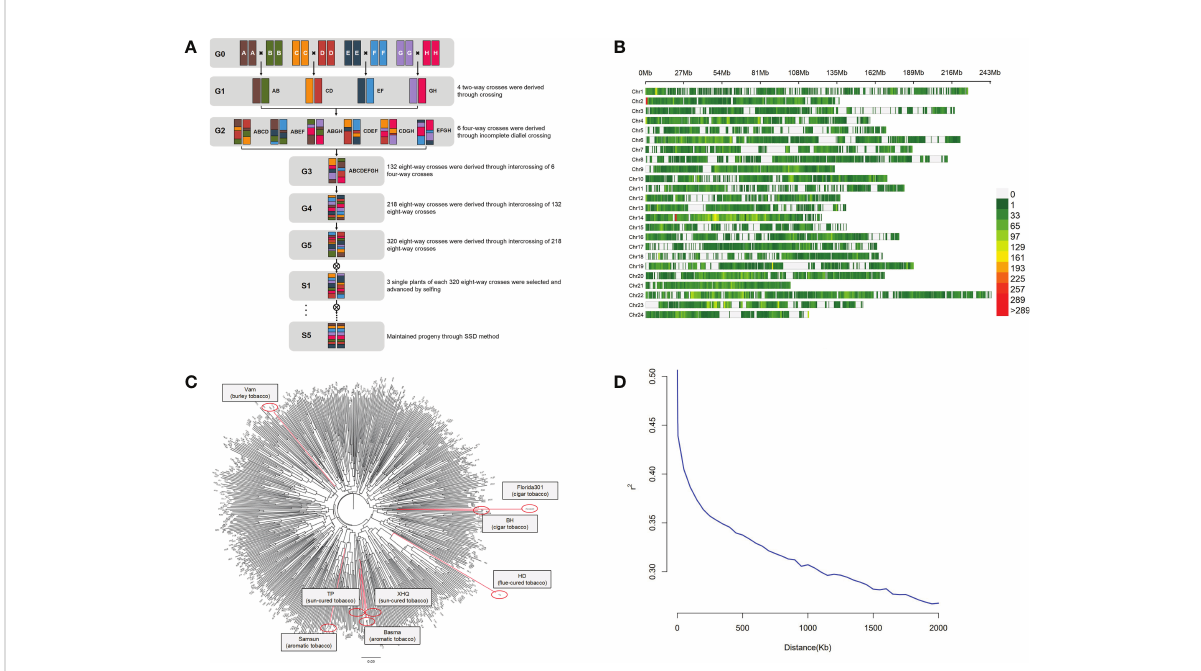
FIGURE 1 Diversity in the tobacco MAGIC population. (A) Breeding scheme of tobacco MAGIC population. Individual color represents each of eight parents (BH, Florida301, Vam, Basma, Samsun, XHQ, TP, HD). (B) Distribution of SNPs in 24 chromosomes. (C) Neighbor-joining tree of the 8 parents and 560 MAGIC lines, with parents labeled in red. (D) Decay of linkage-disequilibrium